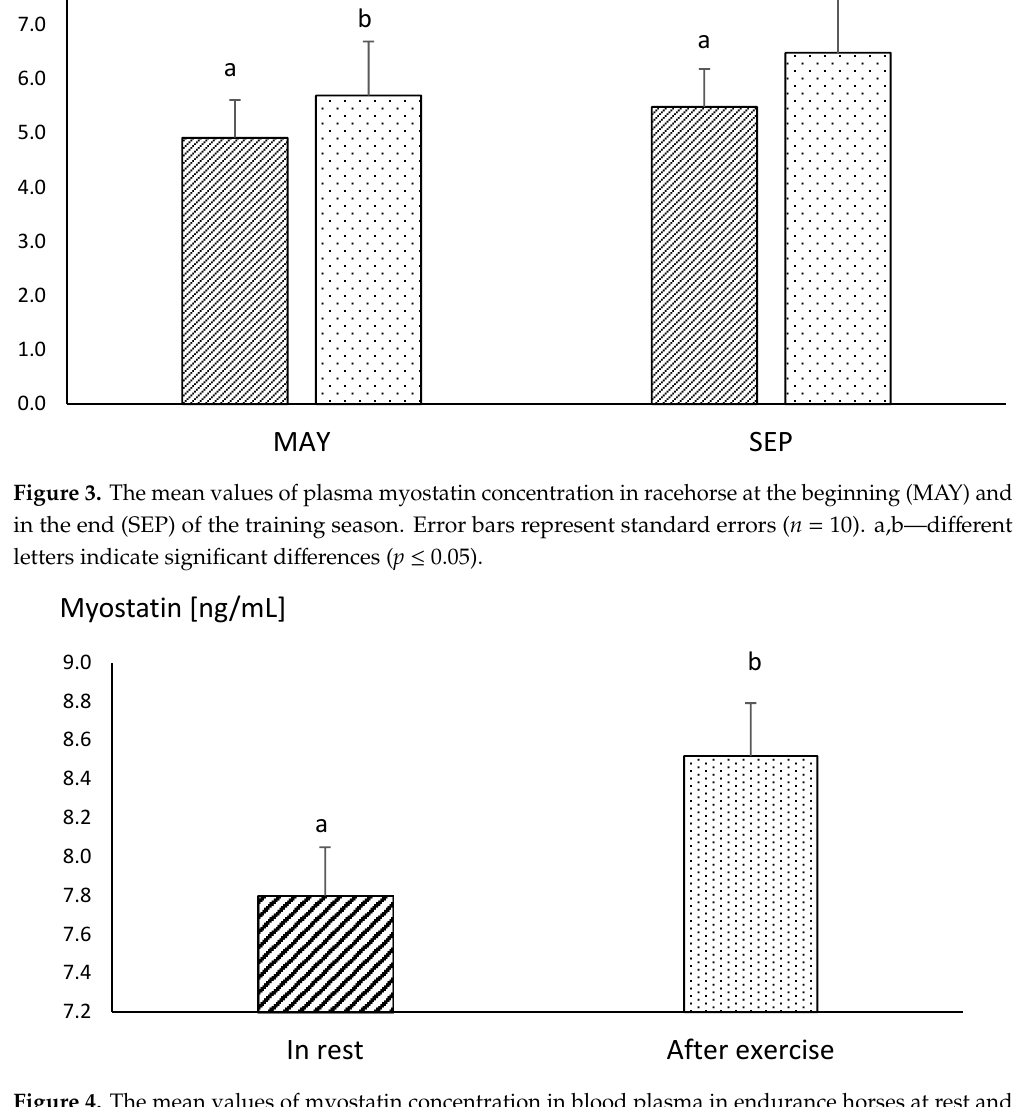
Figure 4. The mean values of myostatin concentration in blood plasma in endurance horses at rest and immediately after the end of the run at the distance of 60 km. Error bars represent standard errors ( n = 10). a,b—different letters indicate significant differences ( p ≤ 0.01)